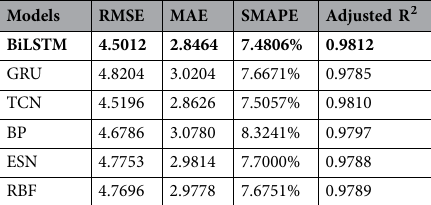
Table 1. Evaluation results of single prediction model indicators. The significant values are in